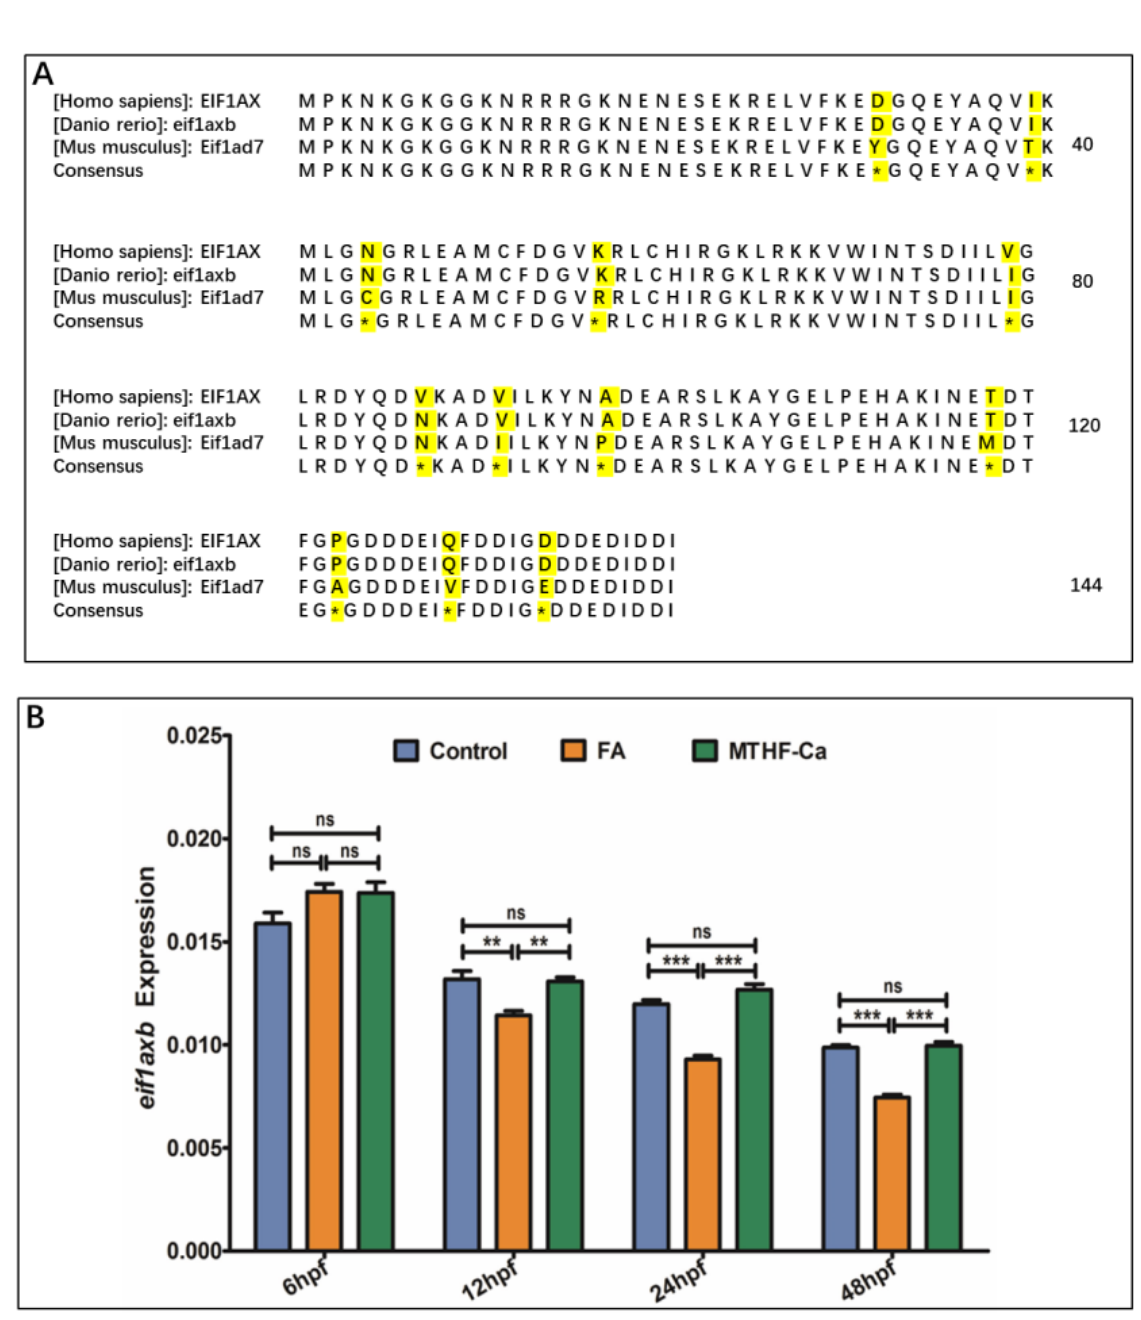
Figure 4. FA, but not MTHF-Ca, downregulates eif1axb expression in a time-specific manner. ( A ) There is a high homology among humans ( EIF1AX ), zebrafish ( eif1axb ), and mice ( Eif1ad7 ). Amino acid sequences of eif1axb orthologs from three species were aligned. The un-conserved amino acids are highlighted in yellow. ( B ) This finding was confirmed by RT-PCR amplification in zebrafish. The expression of eif1axb in zebrafish was significantly downregulated by FA treatment at three embryo development stages (12 hpf, 24 hpf, and 48 hpf) ( n = 30 individual embryos). FA: folic acid; MTHF-Ca: 6S-5-methyltetrahydrofolate-calcium; L: low dose; H: high dose. *** p < 0.001; ** p < 0.01; ns: not significant; hpf: hours postfertilization.